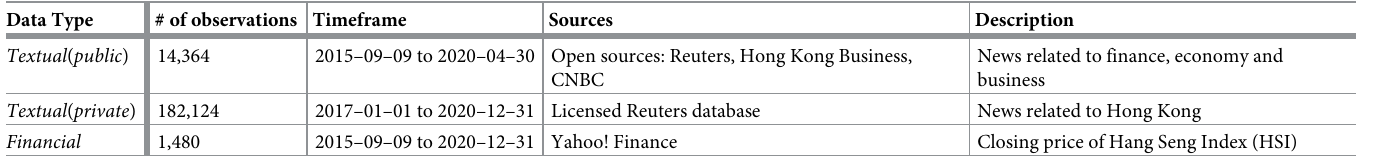
Table 3. Description of the data collected.